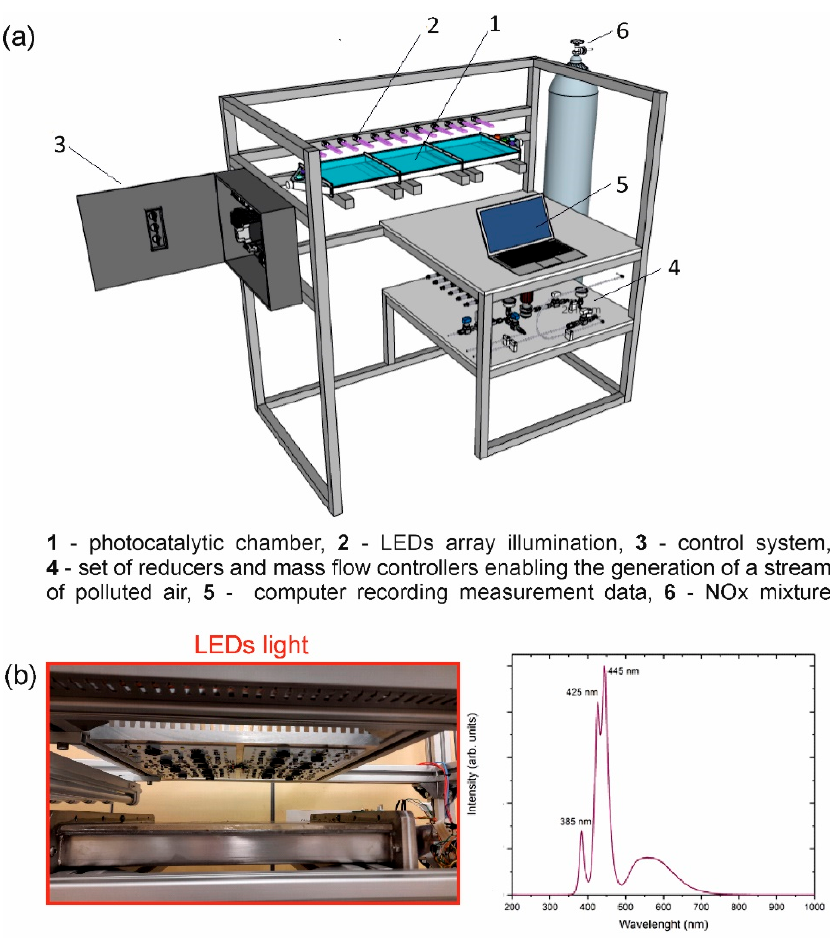
Figure 1. ( a ) Schematic presentation of the experimental setup of a continuous-flow photoreactor; ( b ) equipped with LED panels as irradiation source with an emission spectrum of UV–vis light.